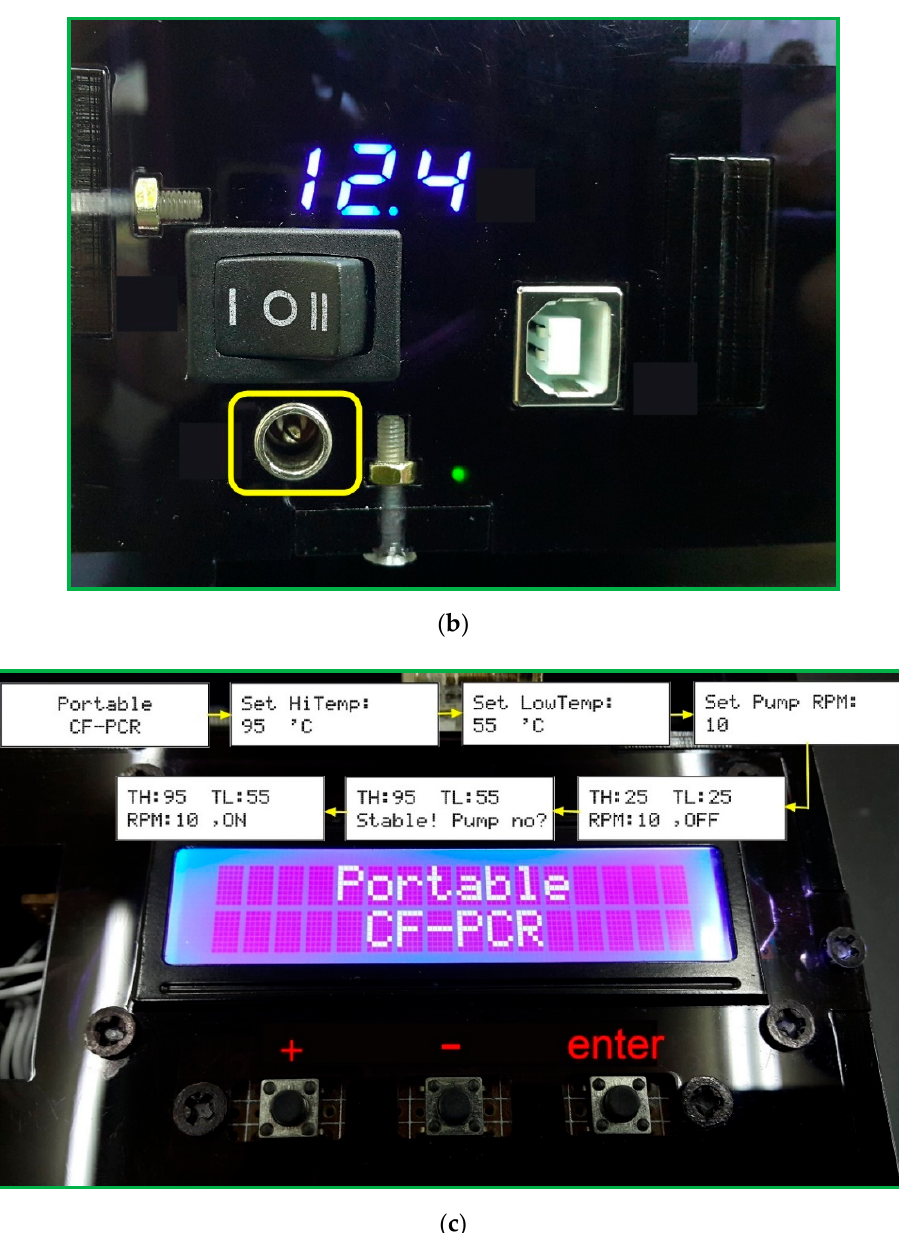
Figure 7. ( a ) A photograph of A DC power of 12.6 V supported by three serial-connected 18650 batteries. ( b ) A choice of 12 V external DC power. ( c ) The user interface sets the operational parameters by pressing the buttons and displays the current status in the LCD 1602A.